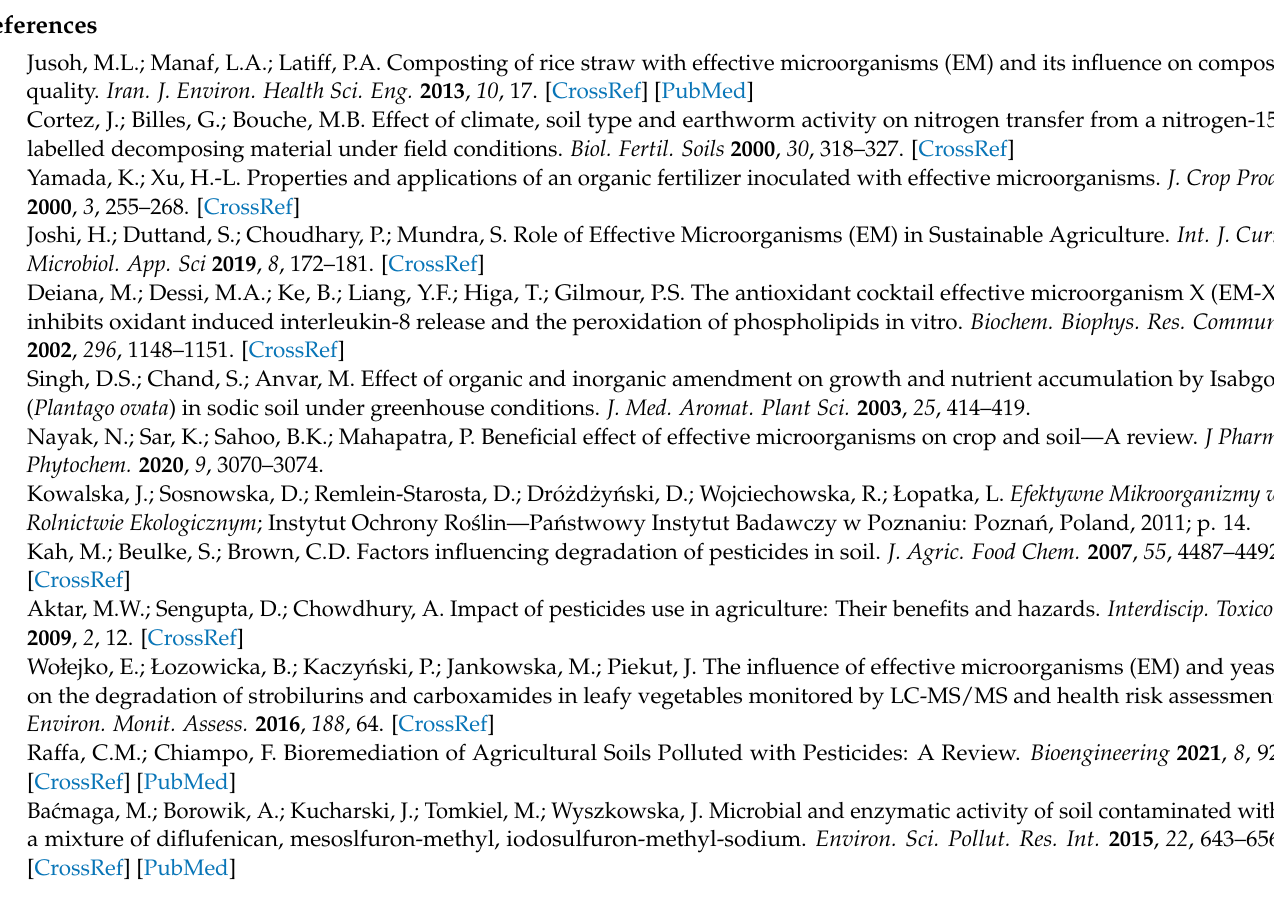
Figure S10: Changes in a moisture content of the soil with flurochloridone and following application of formulations with EM in time; Figure S11: Changes in the oxidoreduction potential of the soil with diflufenican and following application of formulations with EM in time; Figure S12: Changes in the oxidoreduction potential of the soil with flurochloridone and following application of formulations with EM in time; Figure S13: Chromatogram of soil sample with diflufenican (retention time for diflufenican—27.854 min, and internal standard—triphenyl phosphate, TPP—27.794 min); Figure S14: Chromatogram of soil sample with flurochloridone (retention time for flurochloridone—20.515 min, and internal standard—triphenyl phosphate, TPP—27.794